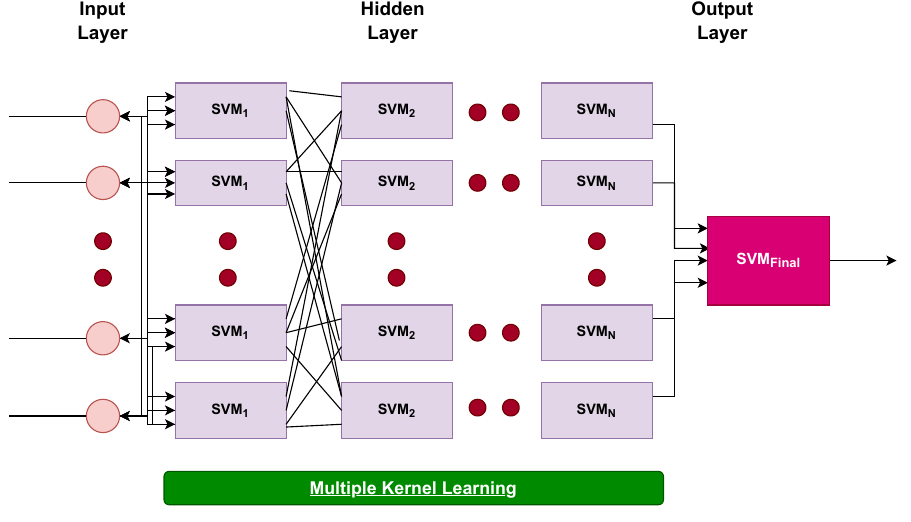
Figure 4. Architecture of proposed deep